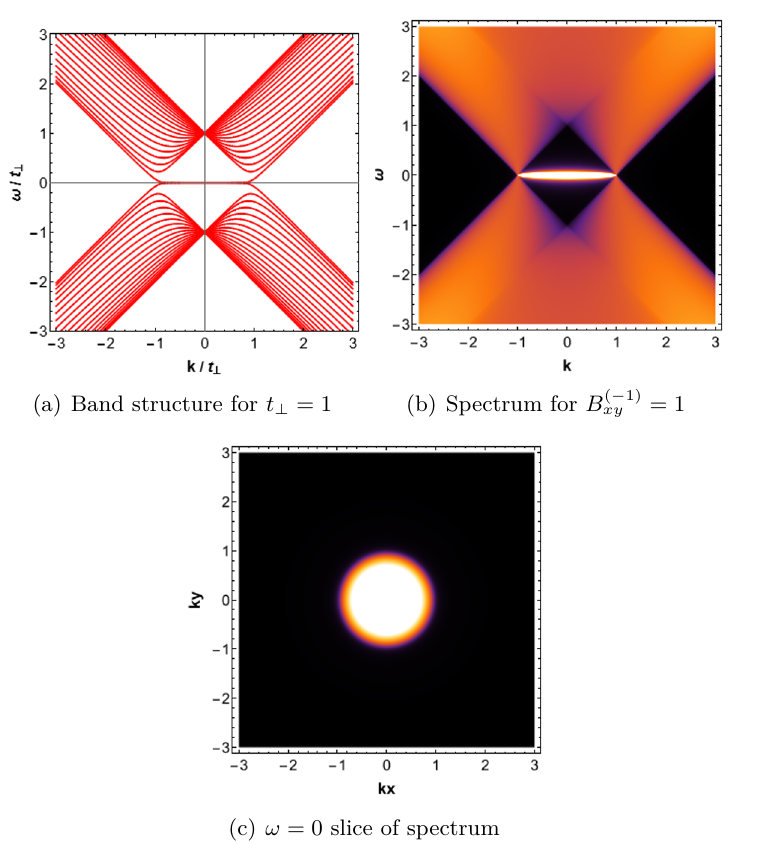
Figure 4 . (a) Band structure of ABC-MLG by tight-binding Model, (b) holographic Spectral function of 2 flavor fermion with B xy interaction with B ( − 1) xy = 1 , k y = 0 (c) ω slice of holographic spectral